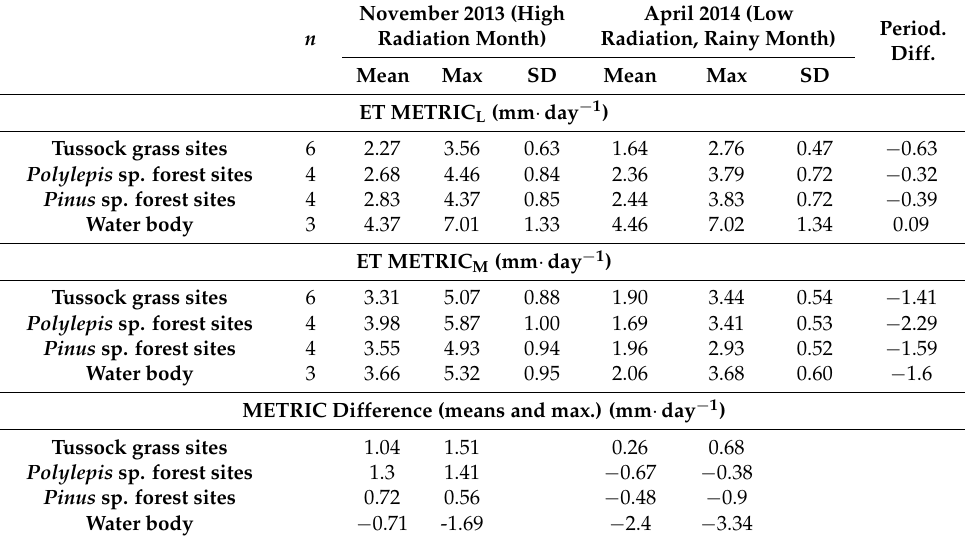
Table 4. METRIC L and METRIC M ET average daily values (mm ¨ day ´ 1 ) according to site